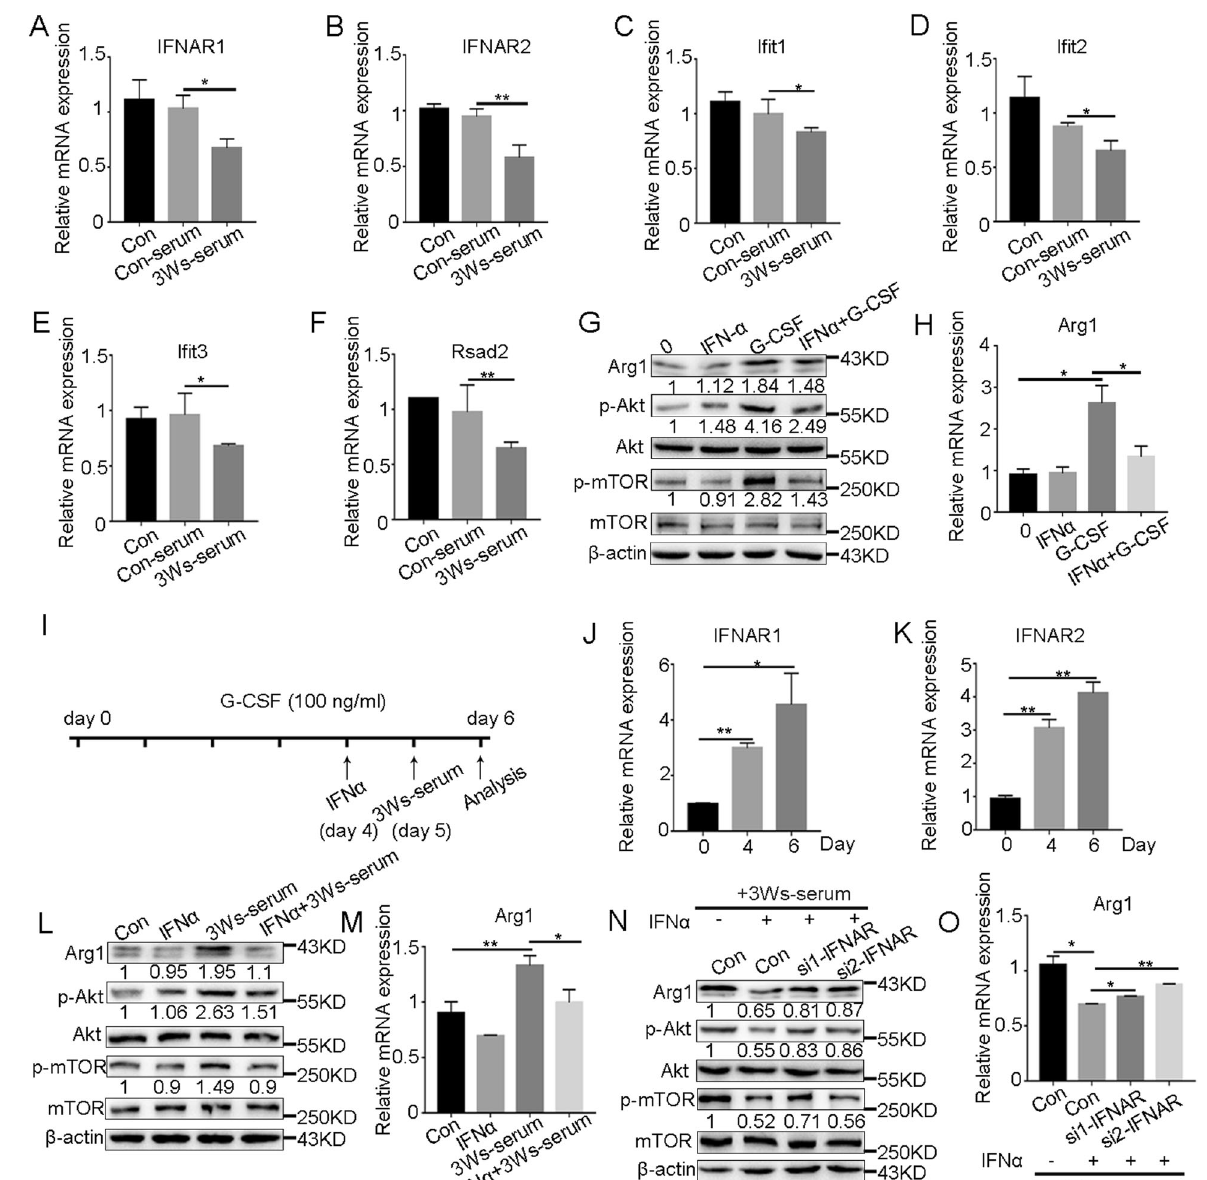
Fig. 6 Downregulation of IFN-I signaling is a prerequisite for G-MDSCs to obtain immunosuppressive functions. A – F The expression of IFNAR and ISGs in G-MDSCs taken from the bone marrow of normal mice was analyzed by Q-PCR after incubation with serum from normal mice or the mice tumor bearing for 3 weeks ( n = 4). G The expression of Arg1, Akt, p-Akt, mTOR, and p-mTOR in G-MDSCs taken from the bone marrow of normal mice was analyzed by western blot after incubation with IFN α (100 ng/ml) or G-CSF (50 ng/ml) for 2 h or stimulation with IFN α for 1 h and subsequent incubation with G-CSF for 2 h (IFN α + G-CSF). H The expression of Arg1 in G-MDSCs taken from the bone marrow of normal mice was analyzed by Q-PCR. The cells were treated as described in G ( n = 4). I Schematic depiction of the experimental design. 32D clone 3 cell maturation was induced with G-CSF. IFN α treatment was performed on day 4, and 3Ws-serum was added on day 5. J , K The expression of IFNAR in 32D clone 3 cells after incubation with G-CSF was analyzed by Q-PCR ( n = 3). L The expression of Arg1, Akt, p-Akt, mTOR, and p-mTOR in 32D clone 3 cells was analyzed by western blot after incubation with IFN α (100 ng/ml) or 3Ws-serum for 48 h or stimulation with IFN α for 24 h and subsequent incubation with 3W serum for 24 h (IFN α + 3Ws-serum). M The expression of Arg1 in 32D clone 3 cells was analyzed by Q-PCR. The cells were treated as described in L ( n = 4). N The expression of Arg1, Akt, p-Akt, mTOR, and p-mTOR in 32D clone 3 cells was analyzed by western blot after incubation with IFN α (100 ng/ml) for 24 h and subsequent incubation with 3Ws-serum for 24 h or after IFNAR interference followed by stimulation with IFN α for 24 h and subsequent incubation with 3Ws-serum for 24 h (si-IFNAR + IFN α ). O The expression of Arg1 in 32D clone 3 cells was analyzed by Q-PCR The cells were treated as described in N ( n = 4). Results are mean ± SD. Unpaired t- test was used to determine signi fi cance (* p < 0.05 and ** p < 0.01). absence of PI3K γ promoted the transformation of macrophages of proliferation and mobilization [50]. In many tumors, high levels into antitumor M1 macrophages [53], and PI3K γ signaling of G-CSF are produced [50 – 52]. Our results indicate that the promoting immune suppression in cancer [54]. The role of the upregulation of G-CSF participates in the initiation of G-MDSCs PI3K-Akt/mTOR axis in G-MDSC differentiation remains largely immunosuppressive function. It has been reported that the